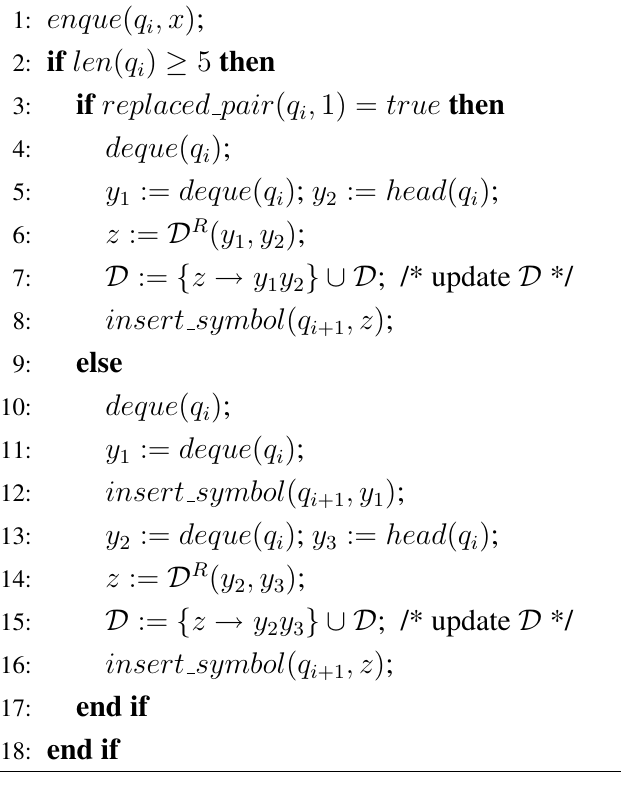
and a symbol x . i